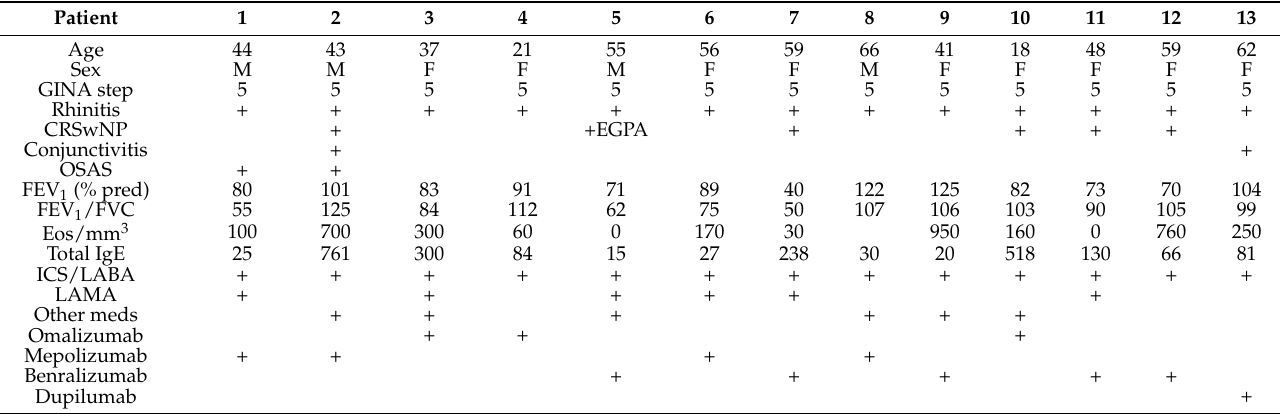
Table 1. Demographic characteristics of the